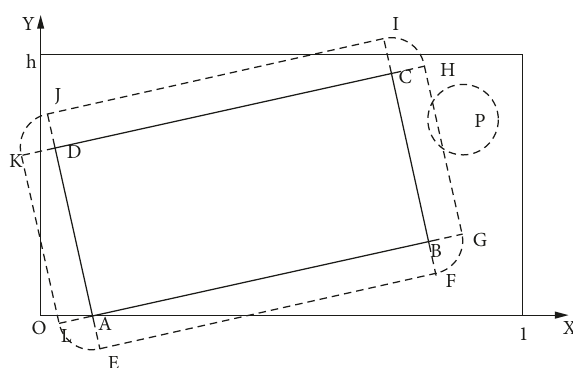
Figure 3: Verification graph of the minimum takeoff and landing